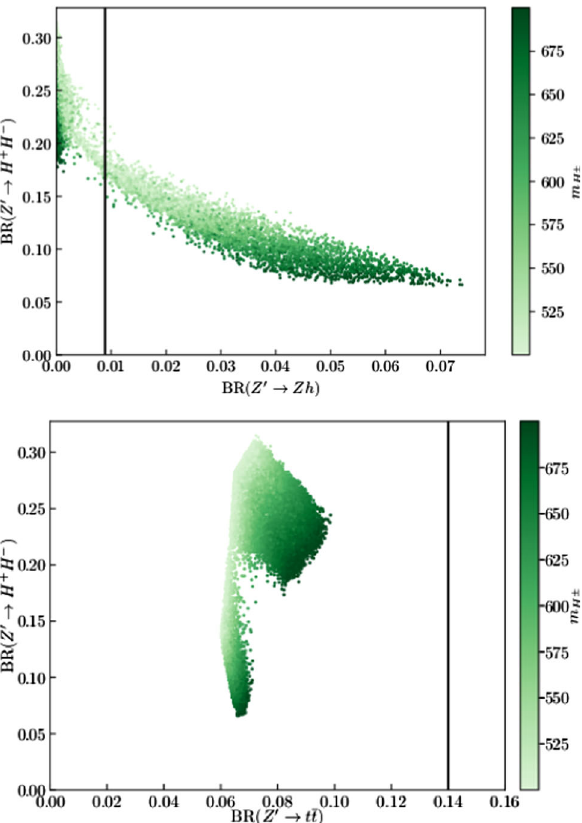
Fig. 4 Branching ratio for Z (cid:2) → H 2 A 0 versus Z (cid:2) → Zh (top) and Z (cid:2) → t ¯ t (bottom) resulting from the parameter space scan in scenario 2. The vertical lines correspond to the experimental upper bound. The colour grading is related to the m H value as shown on the right 2